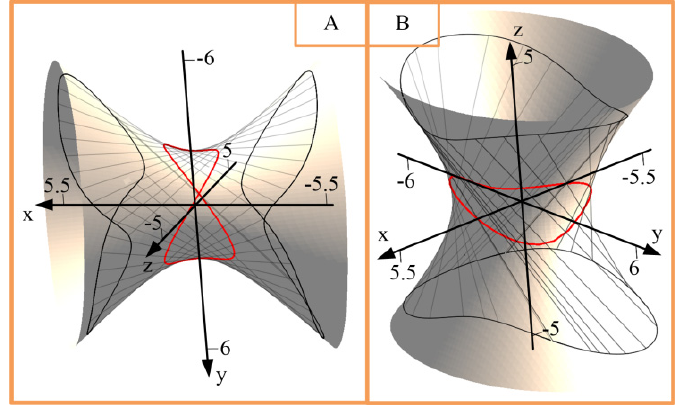
Figure 12. Ruled surface on a pitch − hyperboloid.